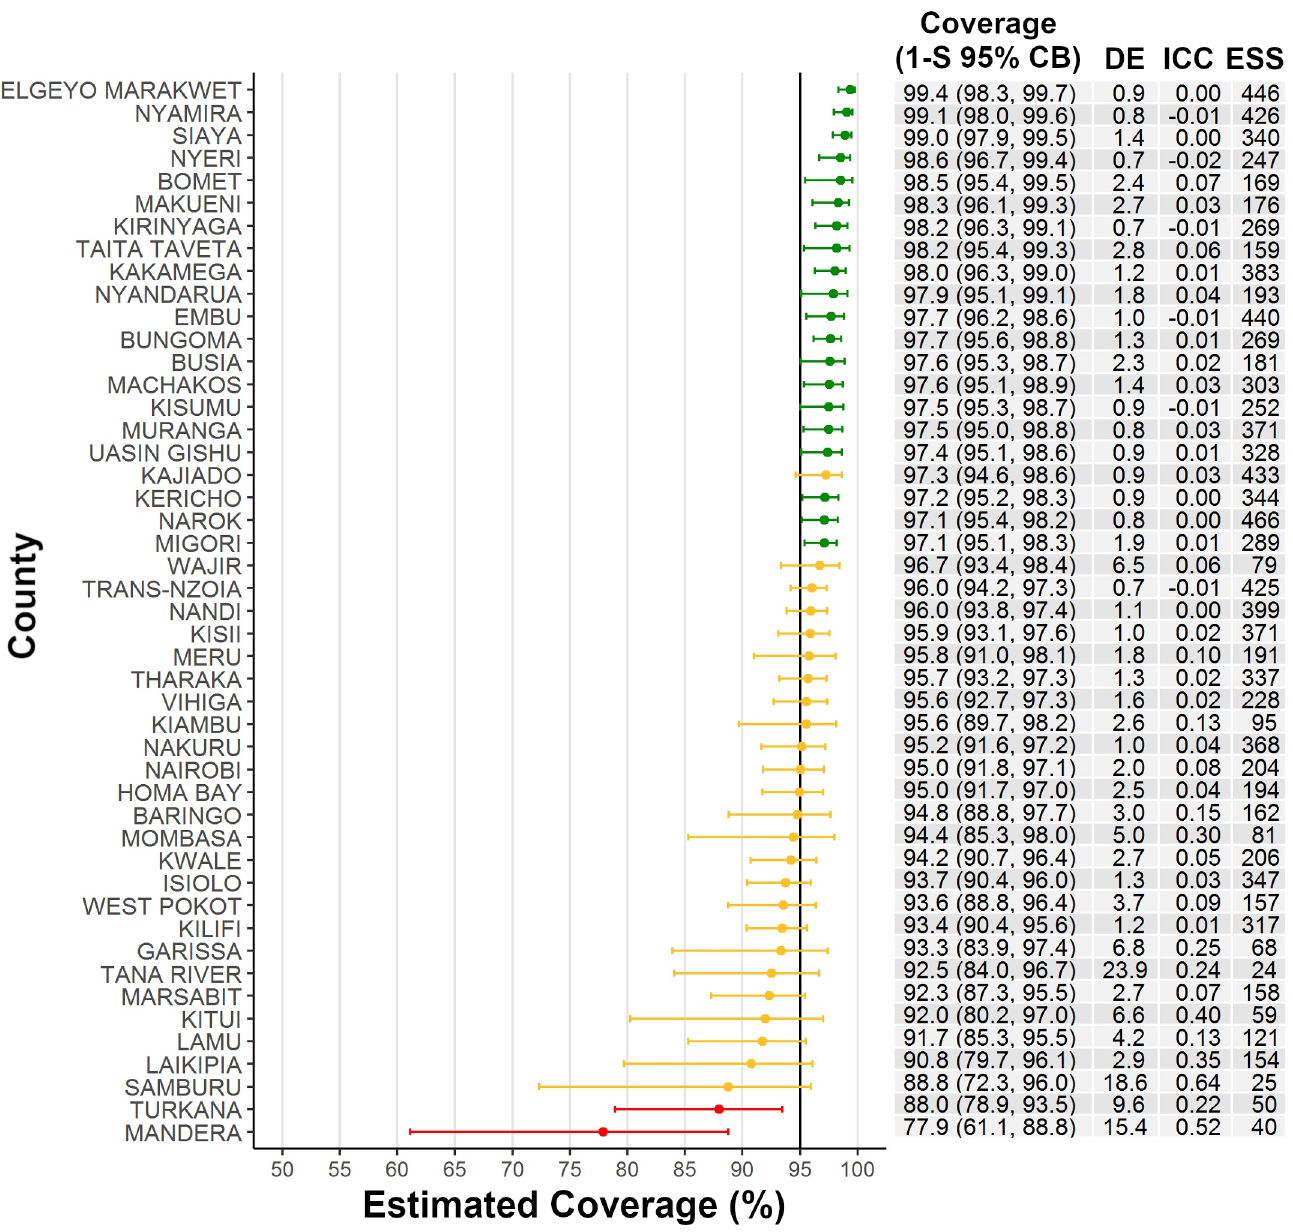
Fig 1. Classification of measles-rubella campaign vaccination coverage by county—Kenya, 2016. Coverage point estimates (one-sided upper and lower 95% confidence bounds [1-S 95% CB]) for children aged 9 months–14 years by country are graphed and printed in the columns to the right of the graph, along with the design effects (DE), intra-cluster correlation coefficients (ICC), and effective sample sizes (ESS = observed sample size / DE; where DE < 1.0, a DE of 1.0 was used to calculate ESS). County coverages colored in green were classified as ‘passing,’ or likely to have coverage (cid:21) 95% (i.e., lower confidence bound was > 95%). Coverages depicted in yellow were classified as ‘intermediate,’ or unable to confidently classify as above or below 95% given the survey sample size (i.e., upper and lower confidence bounds straddled the 95% threshold). Coverages shown in red were classified as ‘failing,’ or likely to have coverage < 95% (i.e., upper confidence bound was below